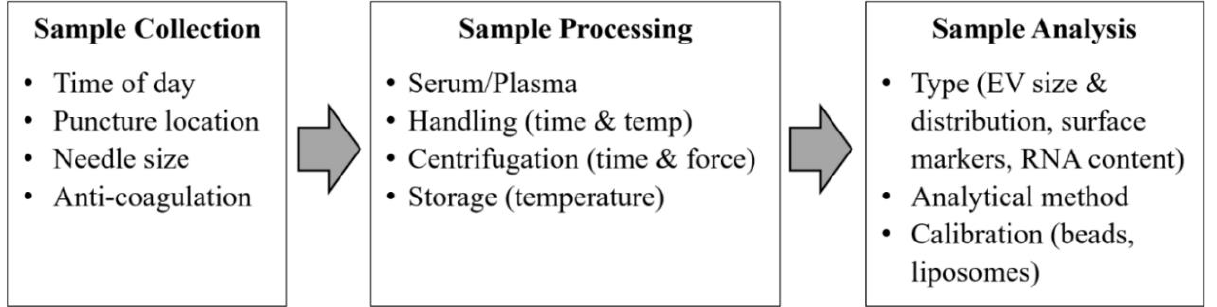
Figure 3. Critical standardization issues for exosomes analysis from blood samples. (Modified with permission from van der Meel R. et al. [37]. Copyright 2014, John Wiley and Sons).